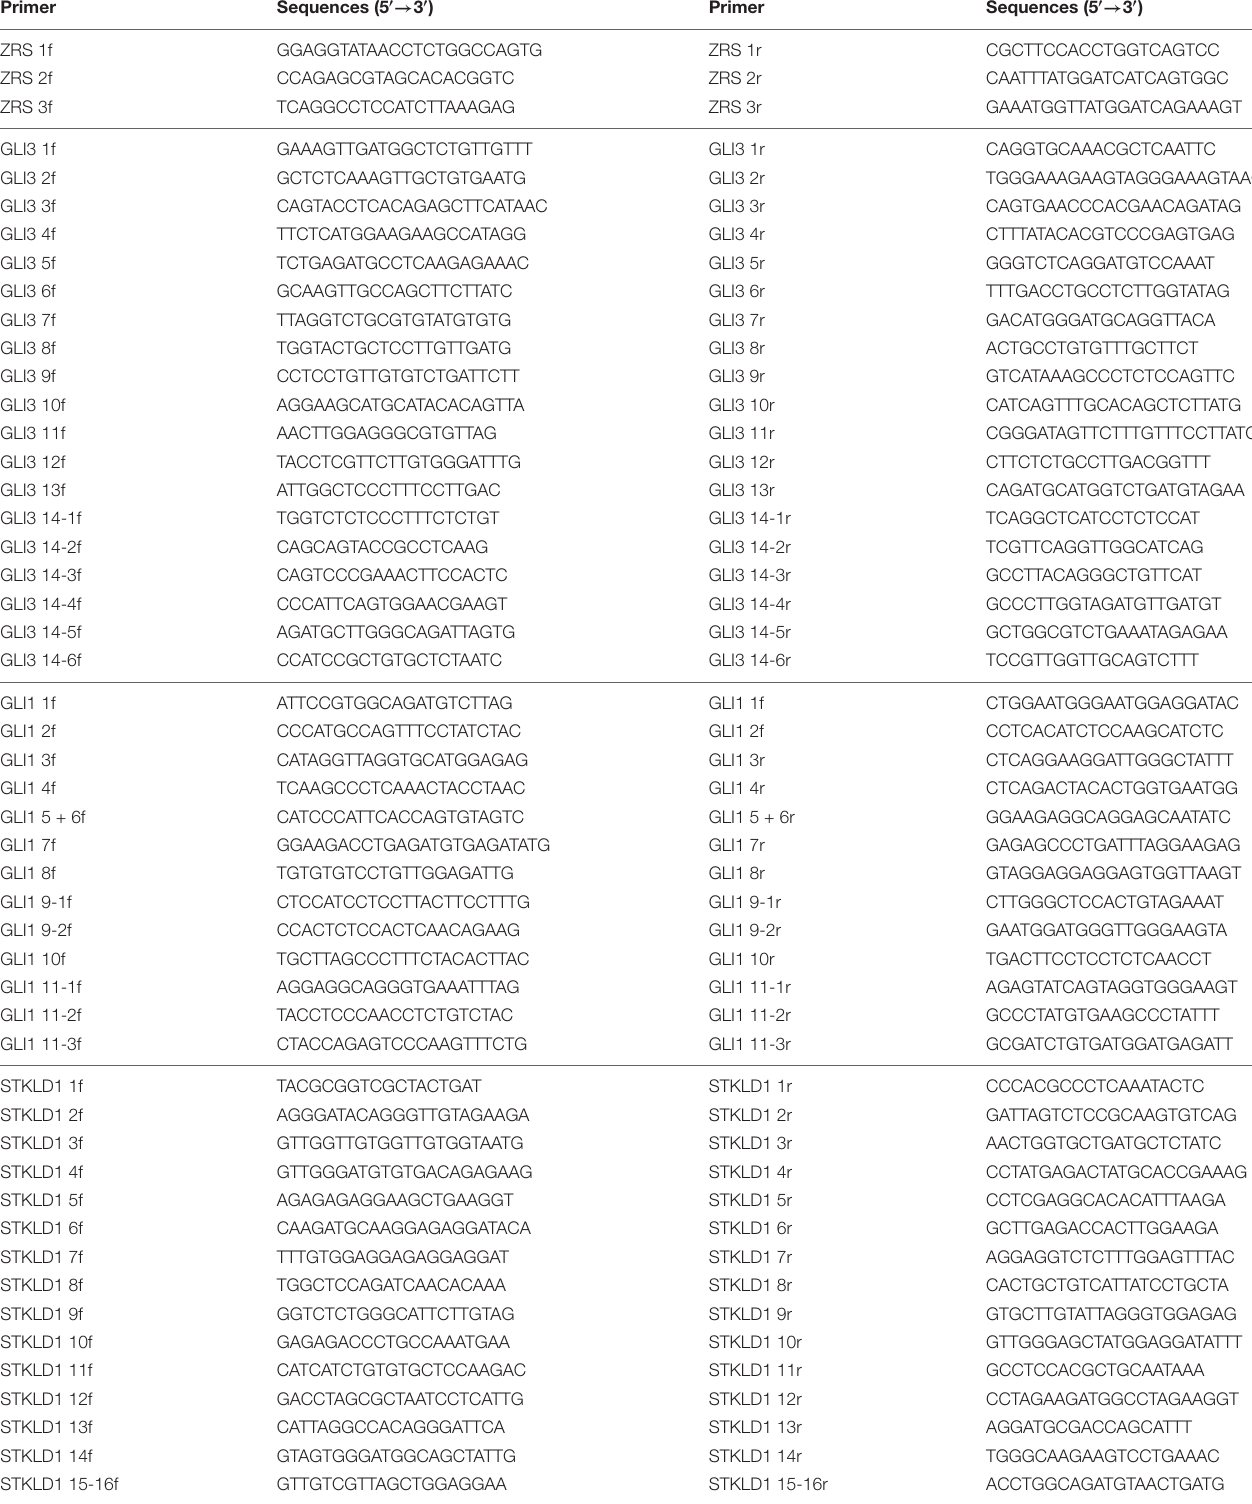
TABLE 2 | Primer pairs of ZPA regulatory sequence (ZRS), GLI3 , GLI1 , STKLD1 , and pre-ZRS. Primer Sequences (5 (cid:48) → 3 (cid:48)